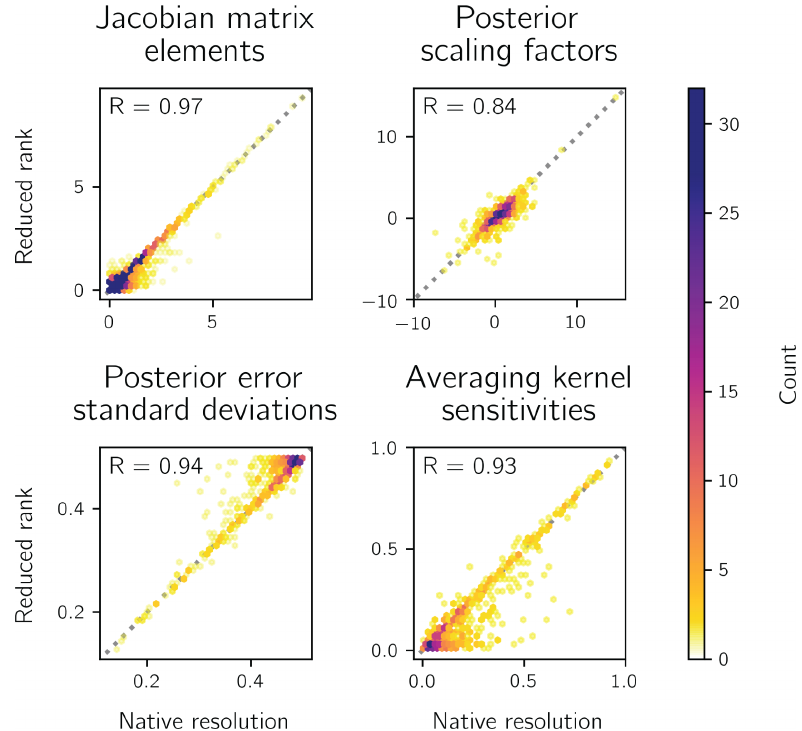
Figure 5. Comparison statistics between the reduced-rank and native-resolution inversions for the grid cells with reduced-rank averaging kernel sensitivity greater than 0.01. Individual panels compare binned counts for Jacobian matrix elements (parts per billion), posterior scaling factors (dimensionless), posterior error standard deviations (dimensionless), and averaging kernel sensitivities (dimensionless). Correlation coefficients are inset, and the 1 : 1 line (dotted) is